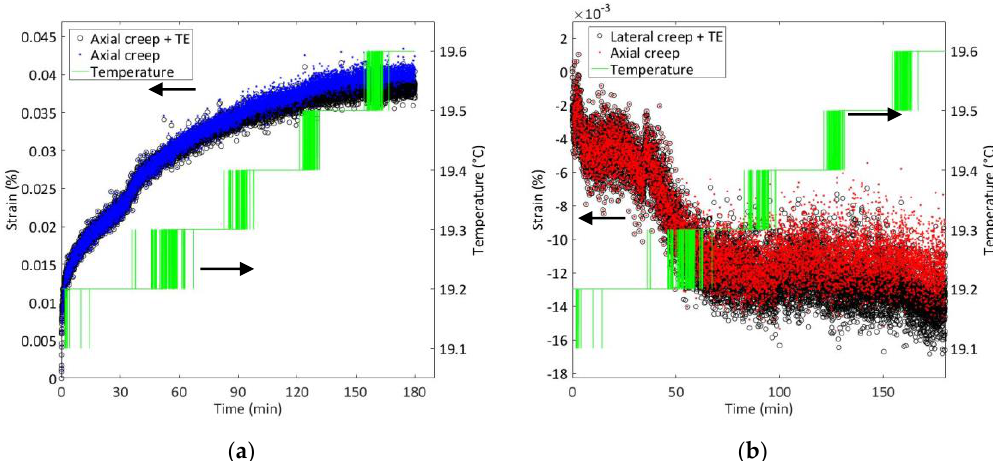
Figure 6. ( a ) Axial and ( b ) lateral creep deformations of LSCF-P20 sample for 3 h under 25-MPa maximum stress superimposed with a temperature measurement during the experiment.